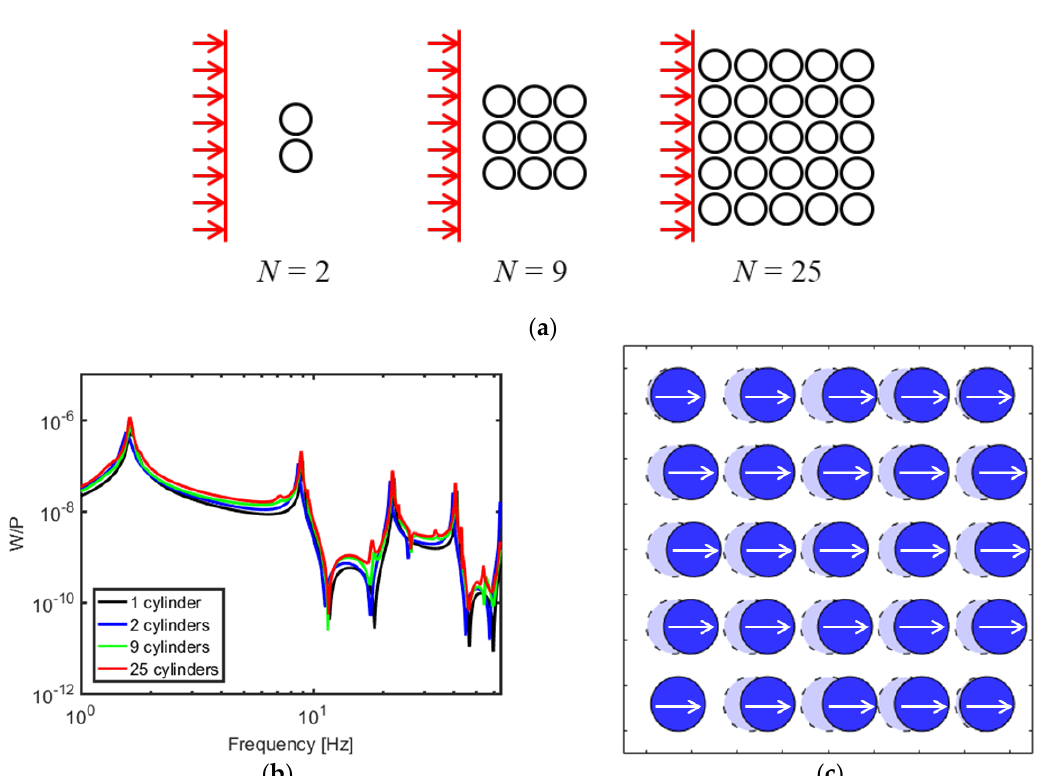
Figure 10. Mode shapes of nuclear fuel rod bundles in the fluid medium: ( a ) N = 9, f = 1.3 Hz; ( b ) 1.6 Hz; ( c ) 2.5 Hz; ( d ) N = 25, f = 1.1 Hz; ( e ) 1.6 Hz; and, ( f ) 9.1 Hz.